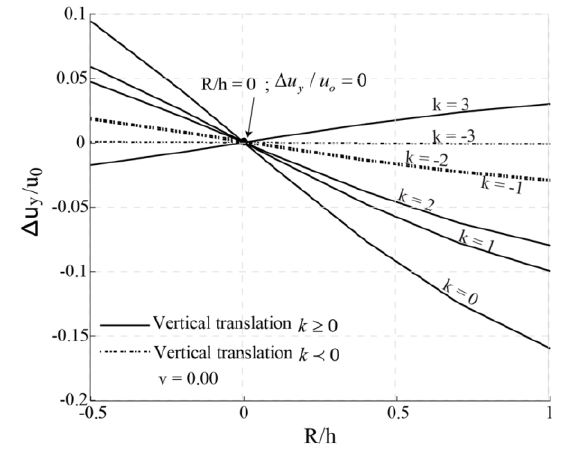
Figure 12. Effect of vertical translation affected by k .